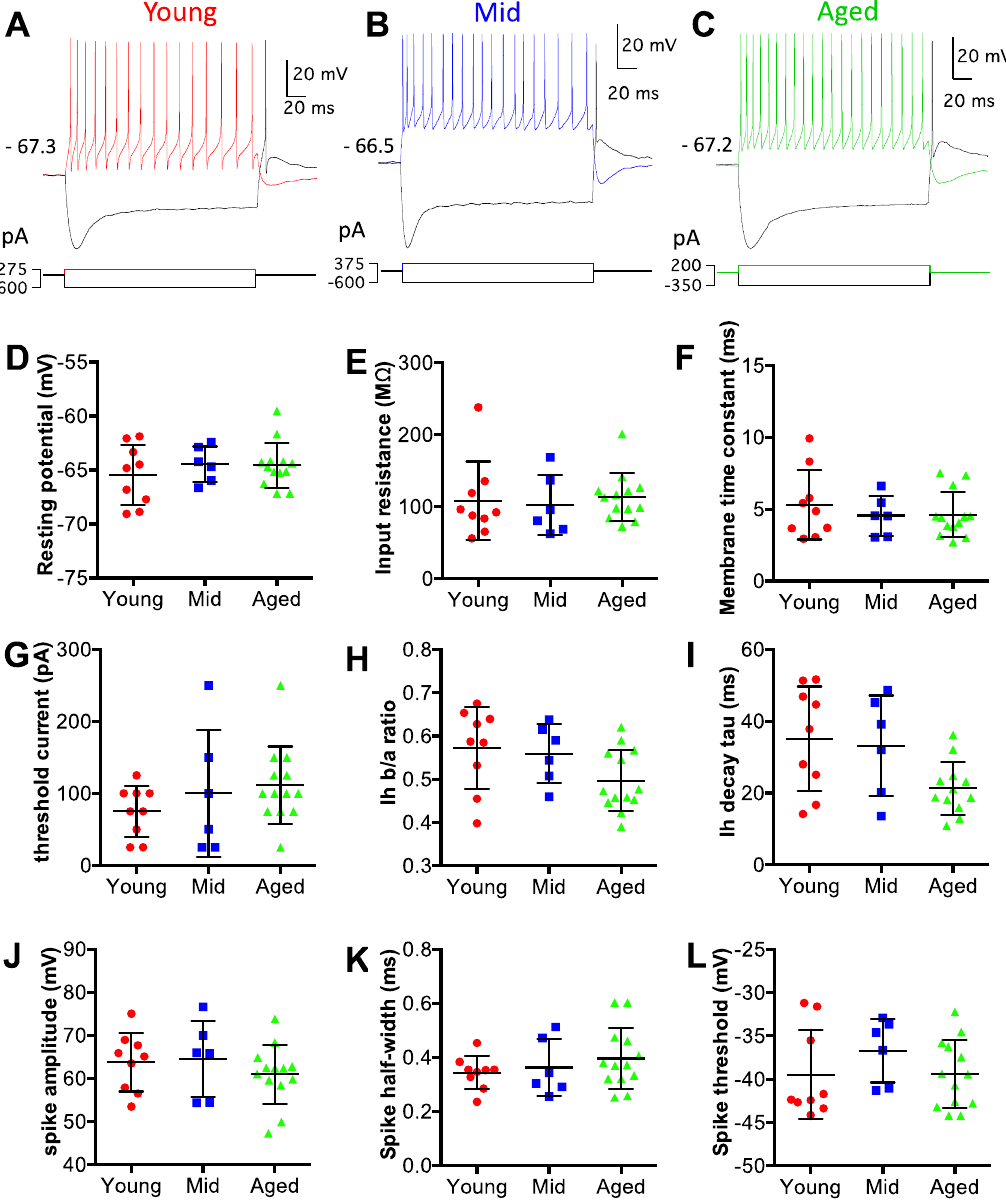
Figure 2. D-stellate neurons show no change in intrinsic membrane properties with age. ( A – C ) Example membrane responses of D-stellate neurons to current injections from three age groups. Numbers mark the resting membrane potentials in mV. Bottom panels: current pulse injections. ( D – L ) Summary plots of all D-stellate neurons in resting membrane potential ( D ), membrane input resistance ( E ), membrane time constant ( F ), threshold current injection to trigger spikes ( G ), depolarization sag steady state versus peak ratio ( H ), depolarization sag decay time constant ( I ), spike amplitude ( J ), spike halfwidth ( K ) and spike threshold voltage ( L ). Kruskal–Wallis test (non-parametric one-way ANOVA) showed no significant difference in all measurements in ( D – L ) ( p > 0.05).